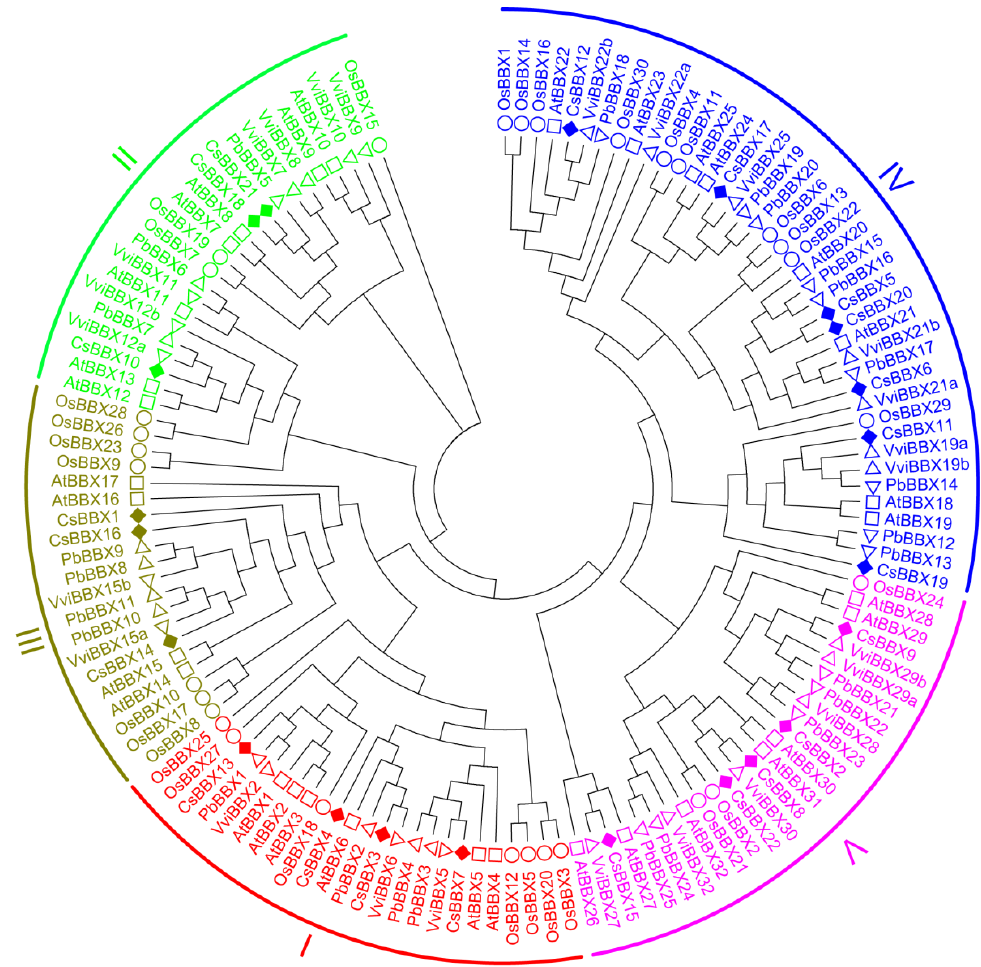
Figure 1. Phylogenetic tree analysis of BBX protein sequences. The full-length BBX protein sequences from Arabidopsis , rice, grape, pear, and cucumber were used to construct the phylogenetic tree with the MAFFT and MEGA 7.0 software. AtBBX, OsBBX, VviBBX, PbBBX, and CsBBX represent the BBX family members of Arabidopsis , rice, grape, pear, and cucumber, respectively. The BBX proteins in the phylogenetic tree were divided into five clades (I–V) with different colors.